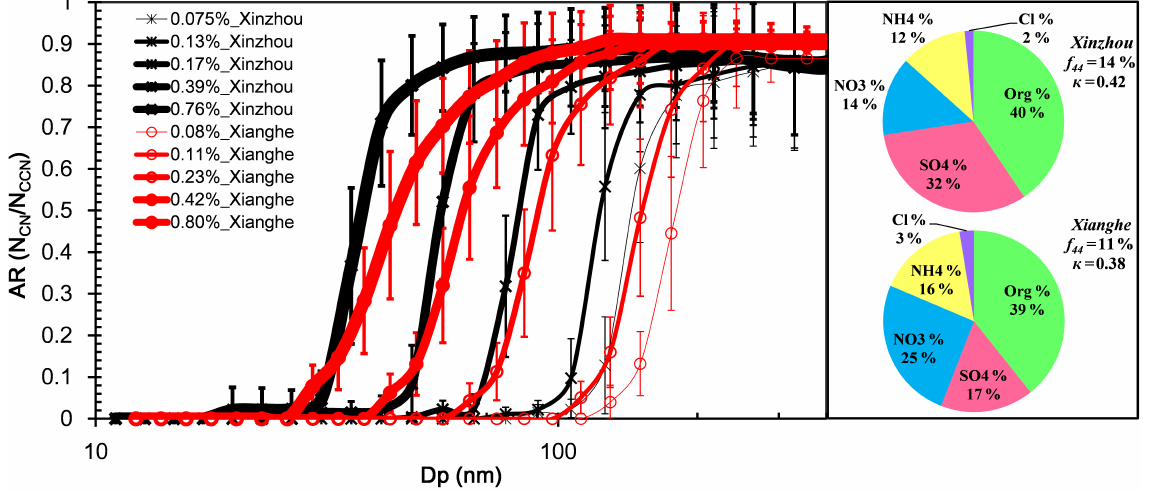
Figure 1. Mean CCN efficiency spectra at the Xinzhou site (black lines with asterisks) measured from 22 July to 26 August 2014 and at the Xianghe site (red lines with circles) site measured from 7 to 21 July 2013 for different supersaturation levels. Error bars representing 1 standard deviation are shown. Right panels show particle chemical composition in terms of mass concentration fractions at Xinzhou (top panel) and Xianghe (bottom panel) during their respective observation periods. The campaign average mass concentration of PM 1 is 31.6 and 72.4µgm − 3 at Xinzhou and Xianghe, respectively. Note that the preset supersaturation levels were 0.07, 0.1, 0.2, 0.4, and 0.8% at both sites, but effective supersaturation levels showed slightly different after